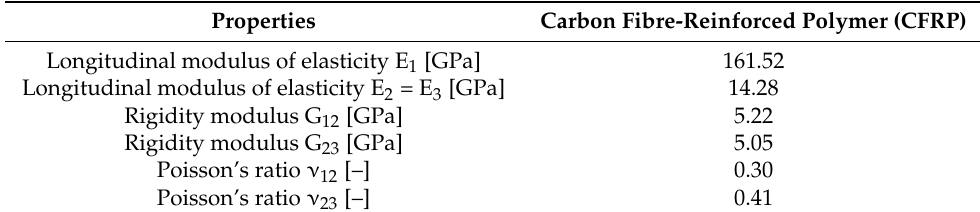
Table 3. Effective elastic properties of the manufactured composites.